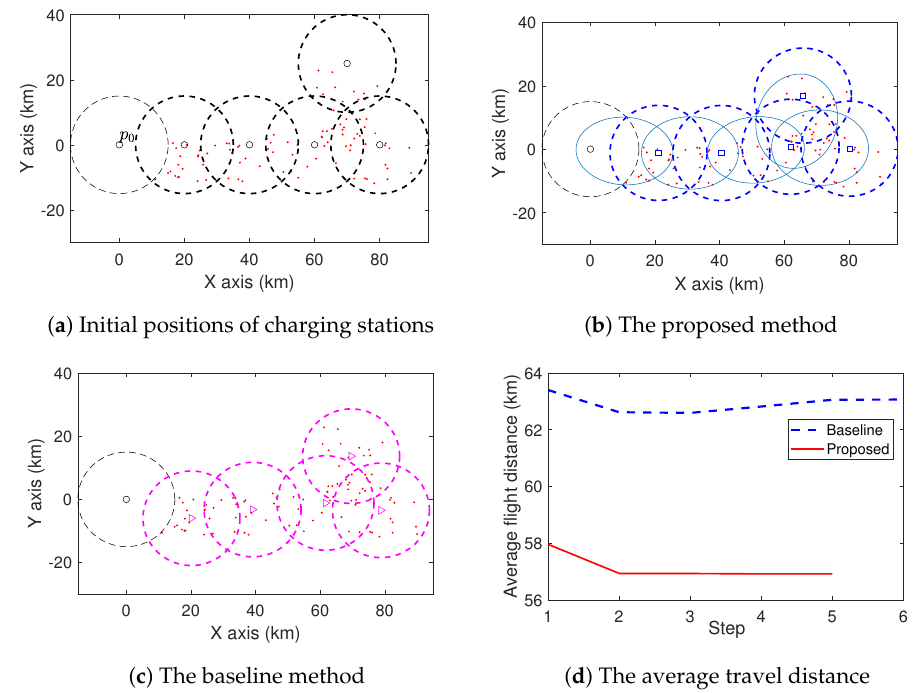
Figure 8. Comparison of the proposed method and baseline method in the case with five charging stations. The sites are represented by red